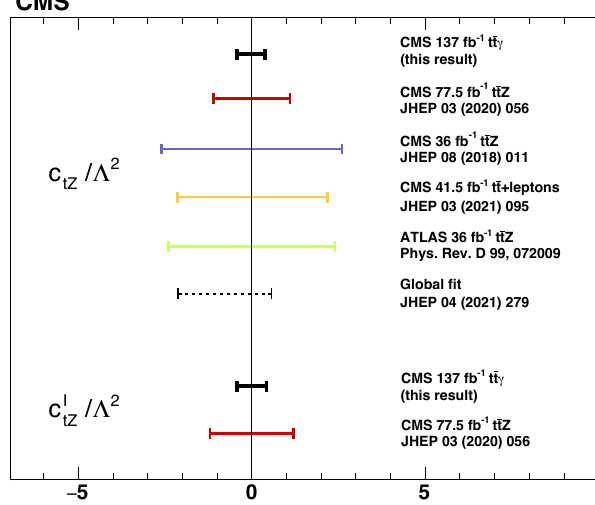
Figure 14 . The observed 95% CL intervals for the Wilson coefficients from this measurement with the other Wilson coefficient set to zero, the previous CMS results based on the inclusive [99] and differential [97] ttZ cross section measurement, a CMS result based on tt in final states with addi- tional leptons [96], and the most recent ATLAS result [98]. The result of a global SM-EFT analysis, including results from ref. [97], is also shown [100]. The vertical line displays the SM